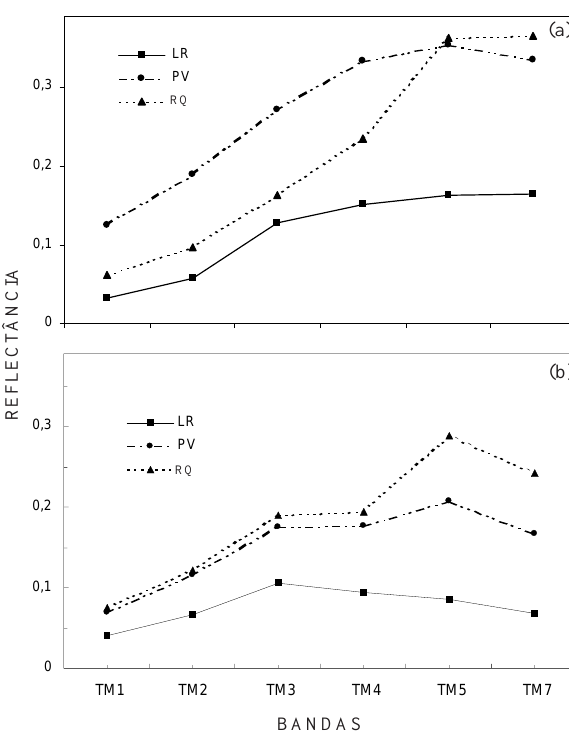
Figura 4. Dados espectrais de laboratório das amostras do Latossolo Roxo, LR (a), Podzólico Vermelho-Amarelo, PV (b) e Areia Quartzosa, RQ (c), nas profundidades de 0–20 e 40–60 cm.